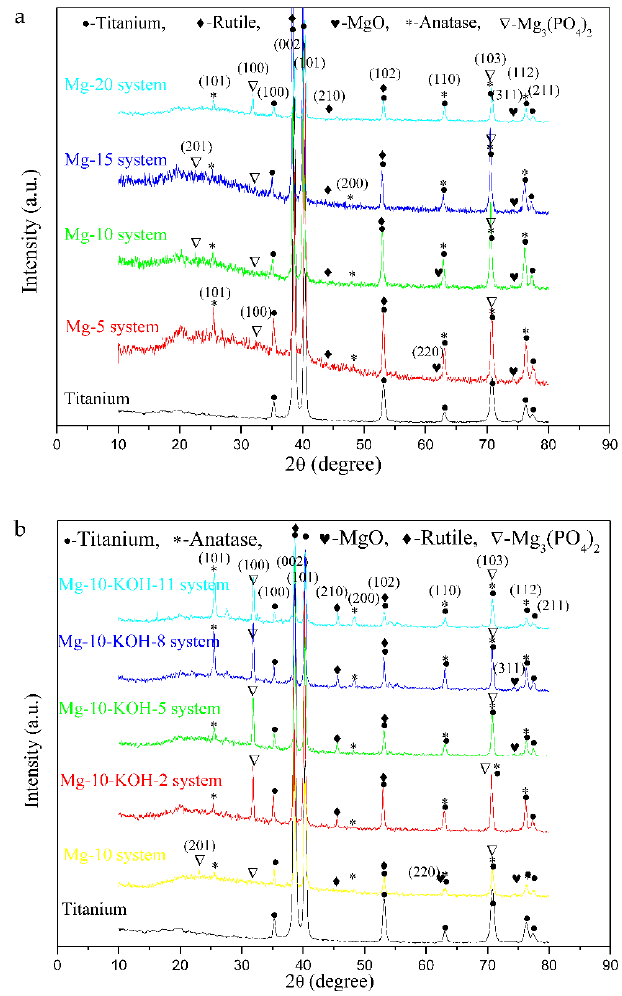
Figure 3. X-ray diffraction patterns of the MAO samples fabricated in ( a ) 15g/L H 12 Phywith 5, 10, 15 and 20 g/L Na 2 MgY and ( b ) 15g/L H 12 Phy and 10 g/L Na 2 MgY without and with 2, 5, 8 and 11 g/L KOH